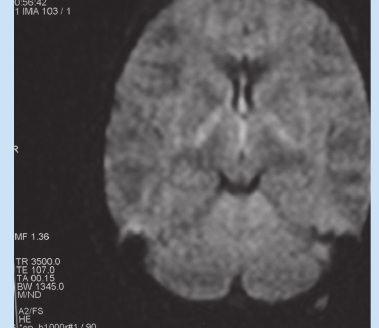
Fig. 1d. DWI with b value = 1000, in the ‘r’ or read out direction – frequency encoding gradient, or x-axis.